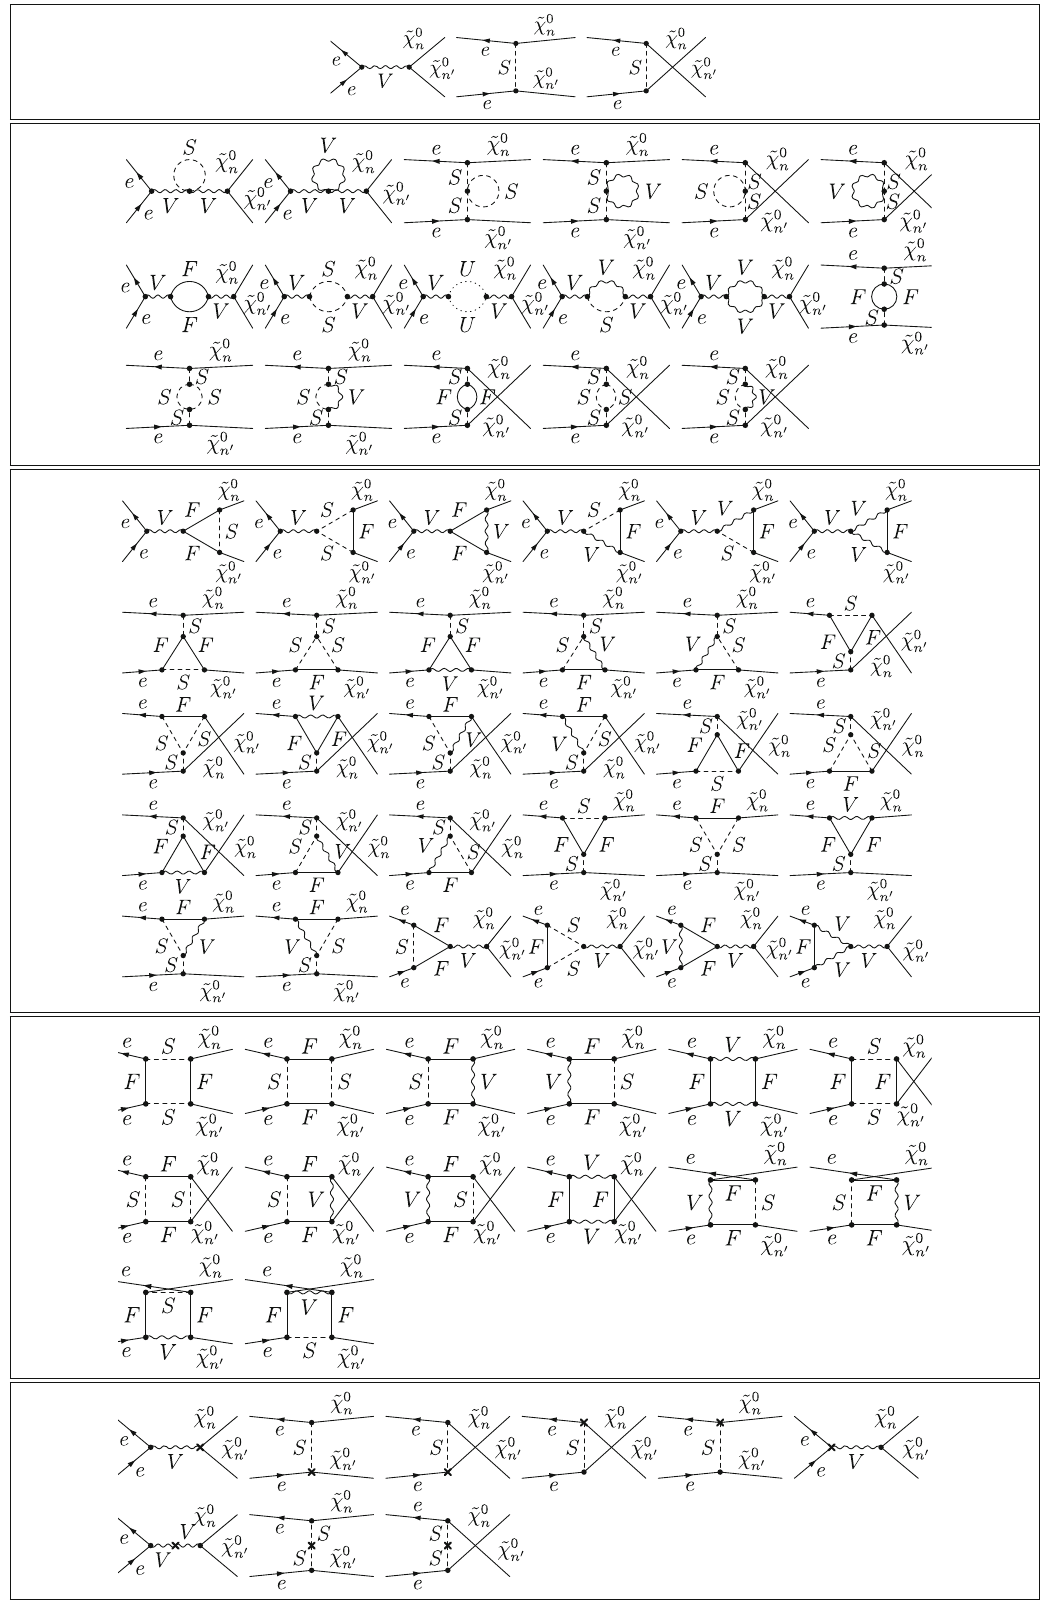
Fig. 2 Same as Fig. 1, but for the process e + e − → ˜ χ 0 n ˜ χ 0